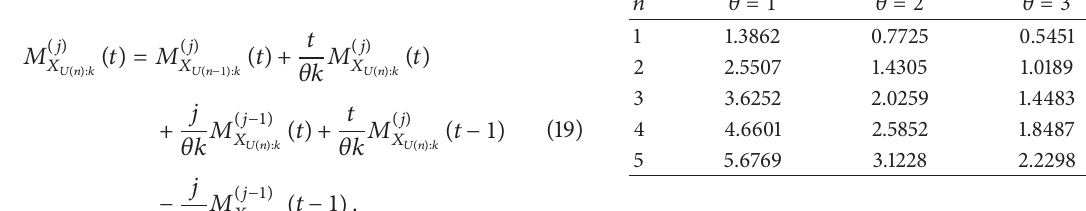
Table 2: Variance of upper